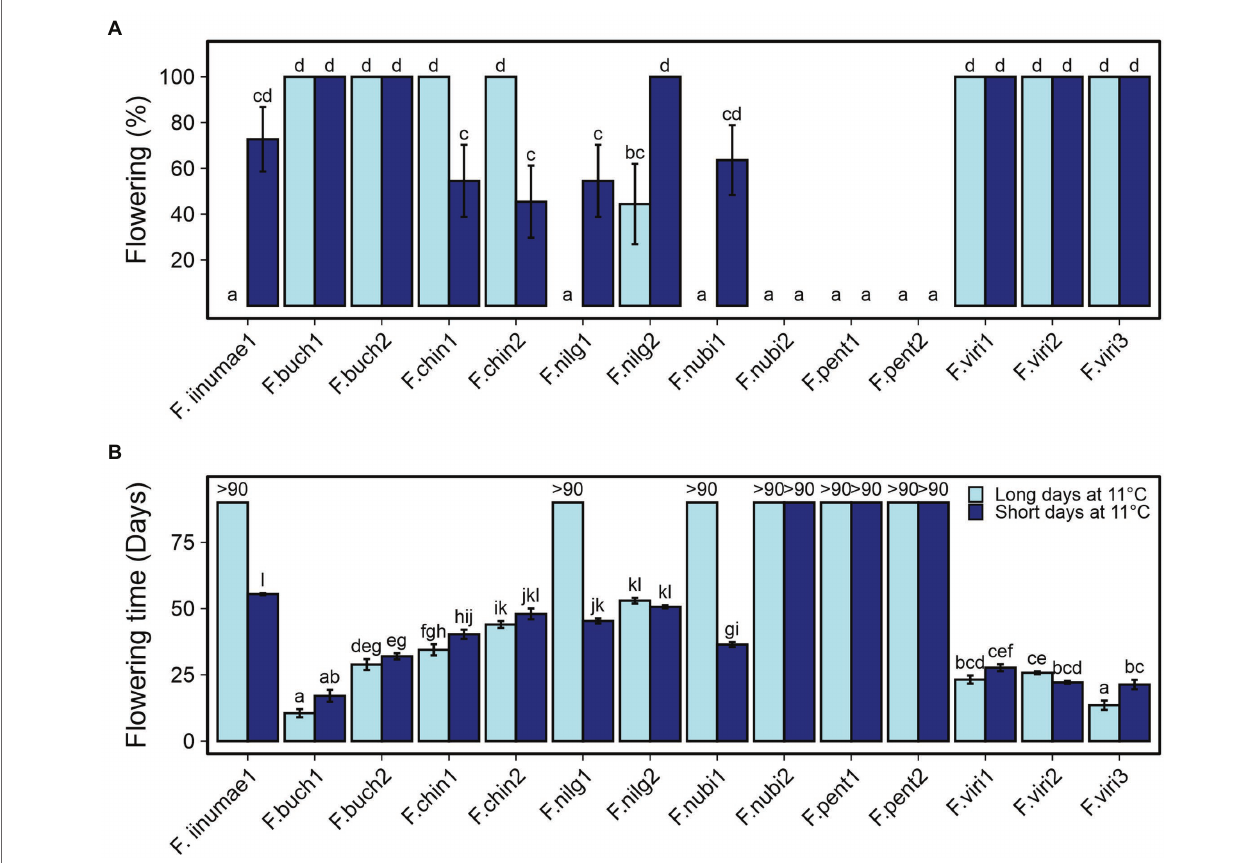
FIGURE 1 | Flowering responses of diploid species to 12 h short day (SD) and 18 h long day (LD) treatments at 11 ° C. Percentage of flowering plants (A) and days to the first open flower (B) . Stolon-propagated plants were grown under 18- or 12-h photoperiod at 11 ° C for 6 weeks followed by LDs (18-h) at 18 ° C. Flowering was recorded every other day, starting after the treatments. Error bars represent the SEM ( n = 7–11), and different letters indicate significant differences calculated by ANOVA and Tukey’s test ( p < 0.05). For accessions that remained vegetative, the number of days recorded is shown